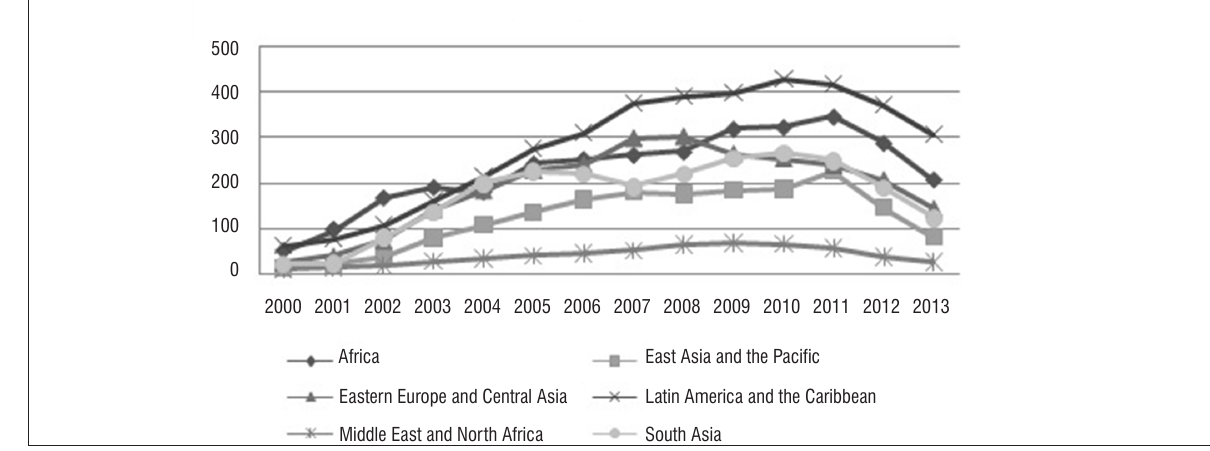
Figure 1: Number of microfinance institutions (2000–2013).